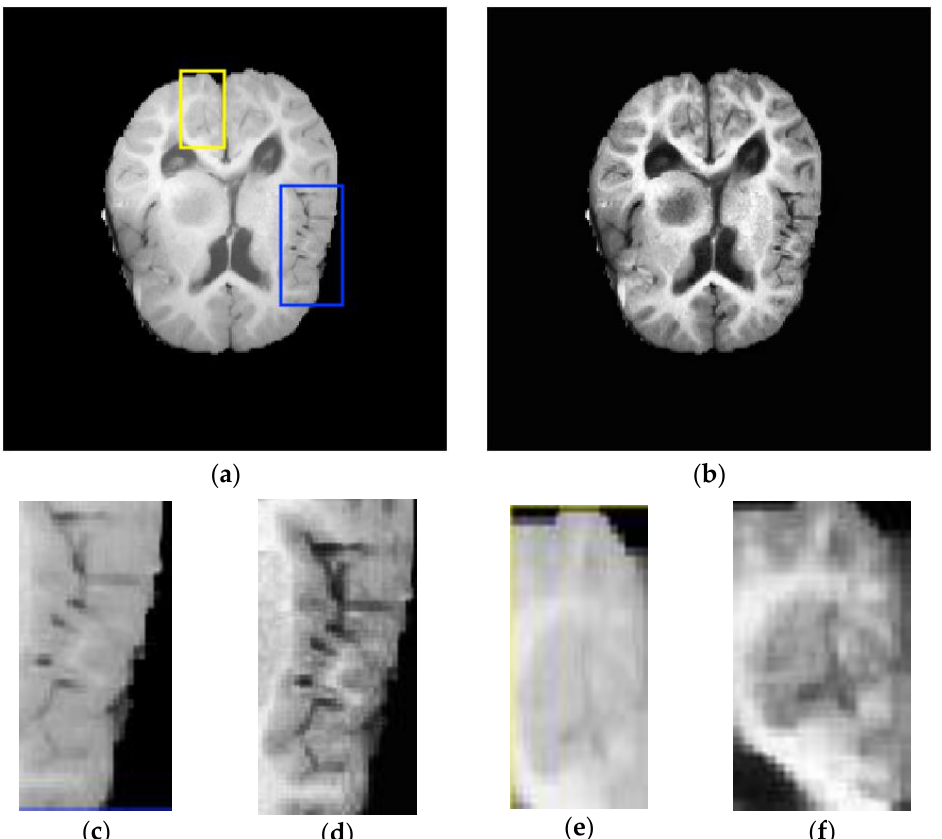
Figure 3. Several challenges (noise, blur effects, and INU artifacts) related to brain segmentation using MR modalities: ( a ) original blur, noisy, and INU slice; ( b ) the resultant slice after the enhancement process; ( c ) original blue line-bounded and magnified region; ( d ) the resultant blue-bounded and magnified region after enhancement process; ( e ) original yellow line-bounded and magnified region; ( f ) the resultant yellow-bounded and magnified region after enhancement process.